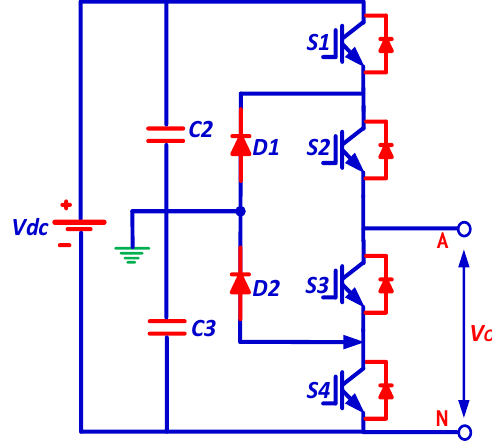
Figure 8. Three-level diode-clamped MLI topology [66].